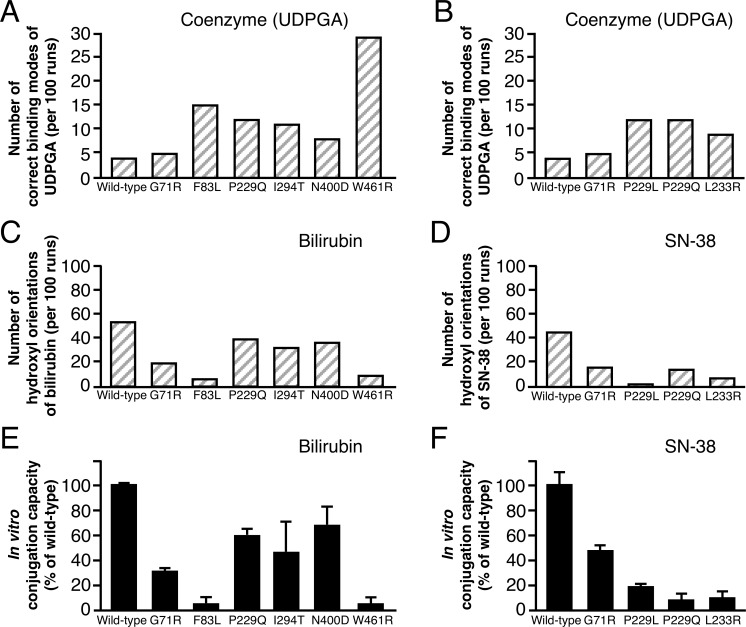
Comparison between docking results and in vitro conjugation capacities of wild-type UGT1A1 and UGT1A1 mutants for bilirubin and SN-38.(A) The number of correct binding modes of UDPGA per 100 separate docking runs. (B and C) The number of hydroxyl orientations of substrate per 100 separate docking runs. S2 Table provides raw data for docking results for panels A, B, C, and D. (E and F) In vitro conjugation capacity.